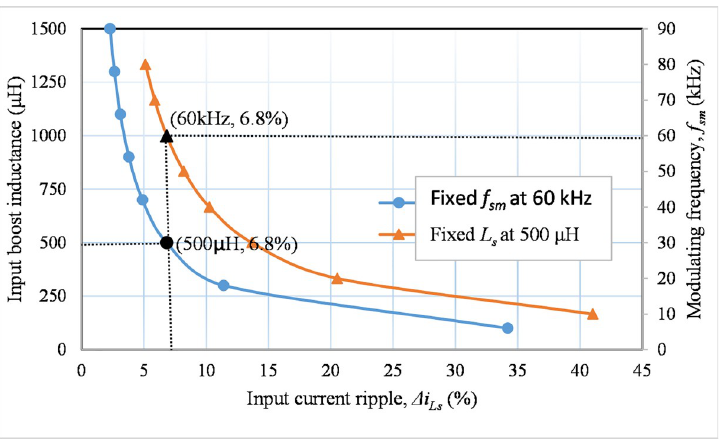
Fig 5. Input current ripple as a function of input boost